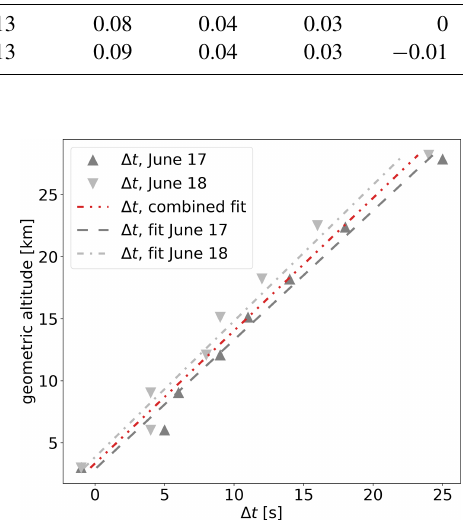
Table 2. Differences between GPS release altitudes and retrieved signal altitudes (cid:49)h . Spike number